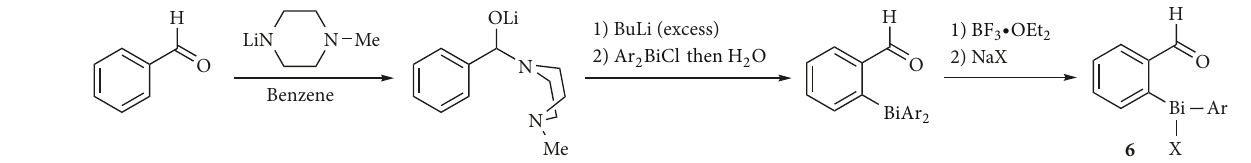
Scheme 4: Conventional synthesis of 6 by directed